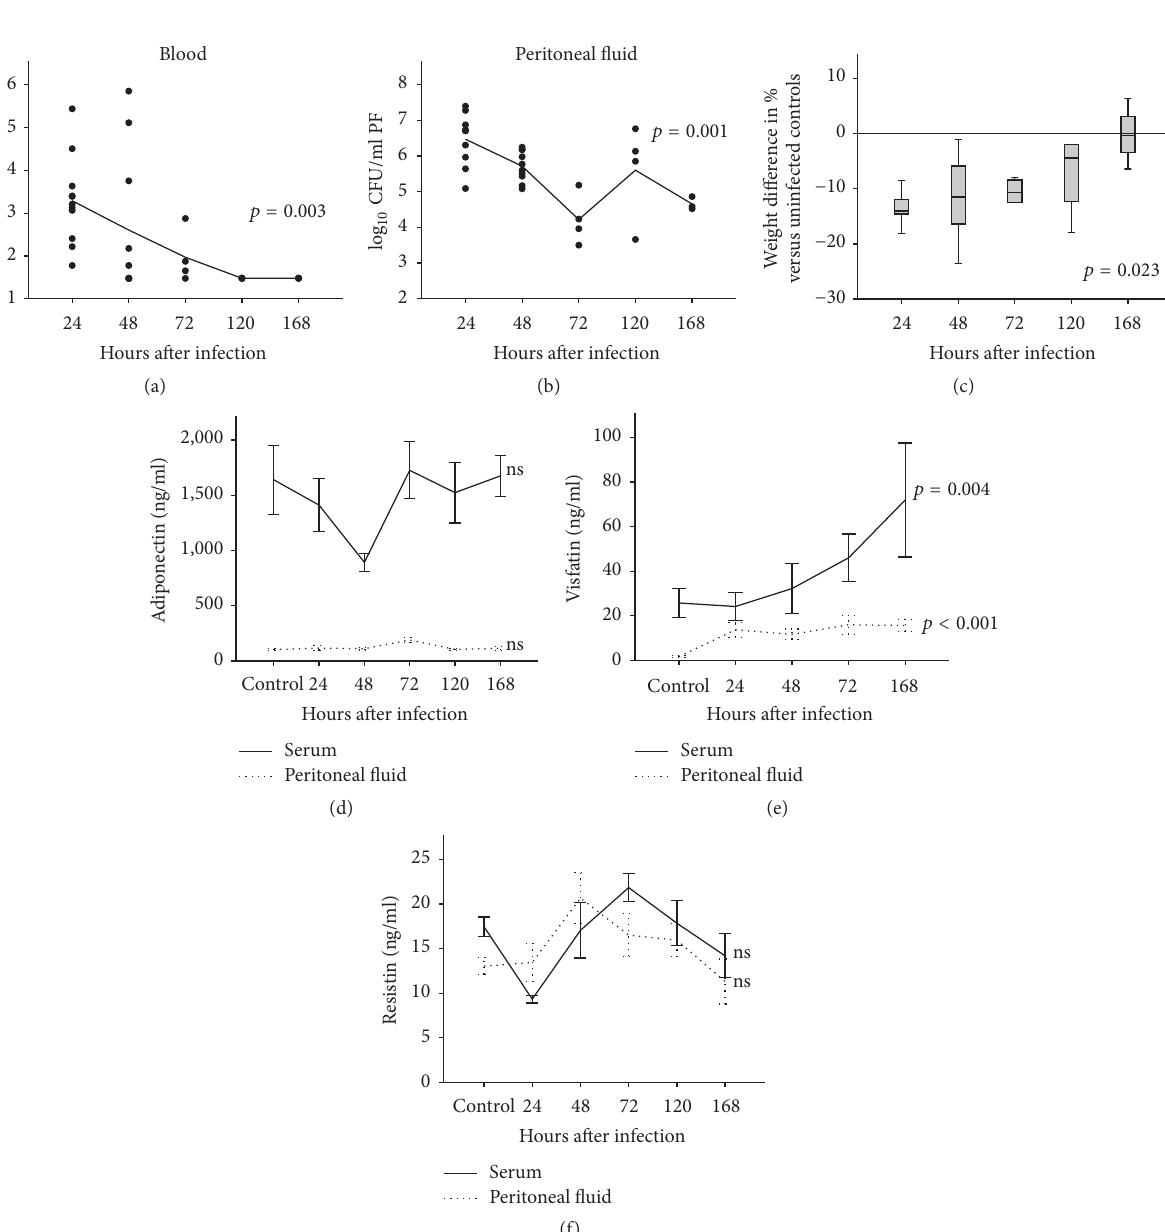
Figure 2: Natural course of nonfatal S. aureus peritonitis and serum/peritoneal fluid adipokine concentrations in an experimental mouse model. Serum, whole blood, and peritoneal fluid were collected from C57BL/6 mice with S. aureus -induced peritonitis. Serum and peritoneal